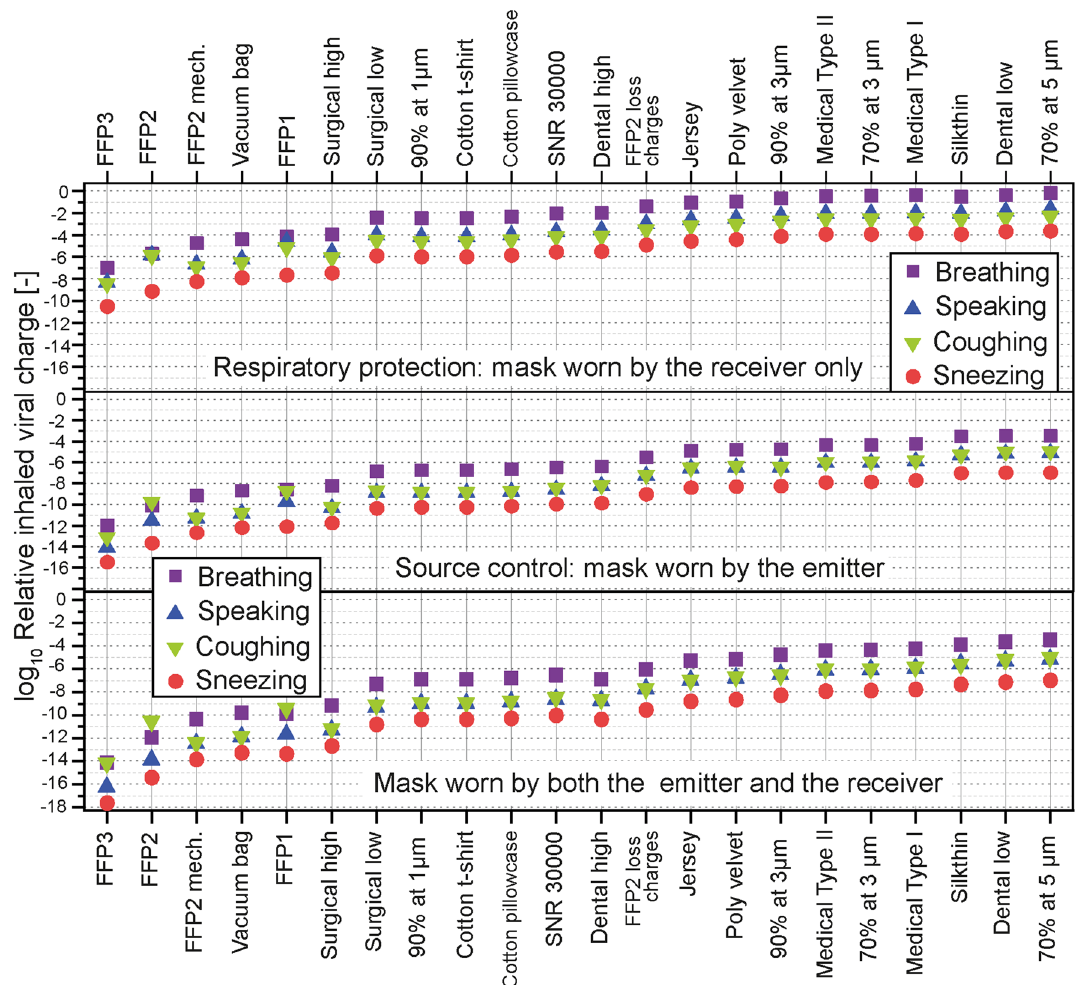
Figure 5. Role of different types of facemasks in reducing the inhaled viral charge. The calculations were based on the viral copies inhaled by a receiver located 0.25 m from the emitter, on the trajectory of the emitted airflow. The masks were considered to be perfectly fitted (no leakage). The data show the relative inhaled viral charge from breathing alone, and together with speaking, one cough, and one sneeze. The viral charge for each emission scenario without a mask was taken as the reference. Three different versions of FFP2 masks are presented: one based only on mechanical filtration (“FFP2 mech.”), a second one including electrostatic filtration (“FFP2”), and a third one models the loss of electrostatic charges (“FFP2 loss